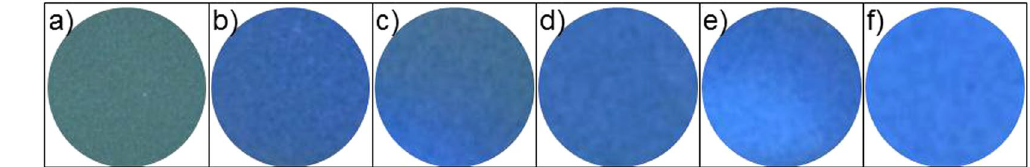
Figure 7. Photographs of TLC plates, soaked in the solution of NS-N 2 H 4 followed by addition of different amounts of hydrazine. ( a ): water; ( b ): 10% N 2 H 4 ; ( c ) 30% N 2 H 4 ; ( d ) 40% N 2 H 4 ; ( e ) 50% N 2 H 4 ; ( f ) 80% N 2 H 4